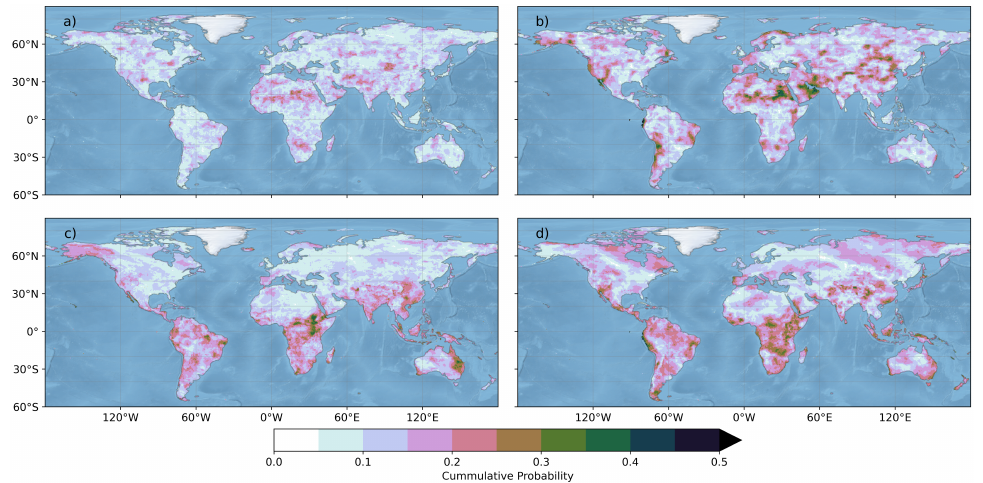
Figure 5. Kolmogorov—Smirnov goodness-of-fit statistic D between reconstructed and GPCP pre- cipitation during the GRACE era ( a ) and pre-GRACE-era ( b ), and between reconstructed and ERA5 temperature during the GRACE era ( c ) and pre-GRACE-era ( d